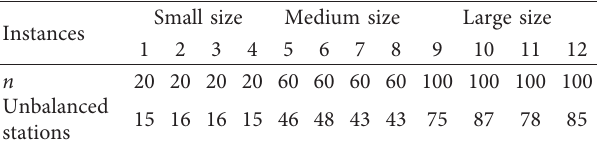
Table 4: Test instances. 12 instances of 3